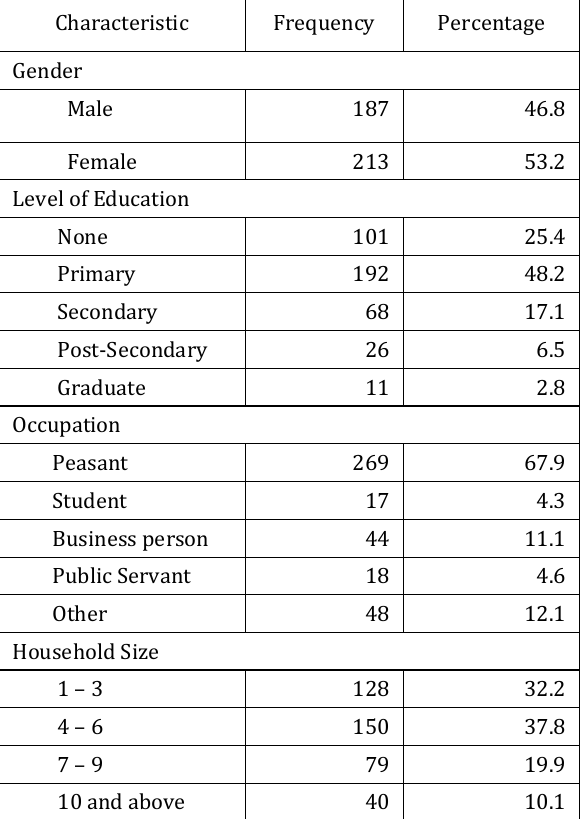
Table 1. Household characteristics of